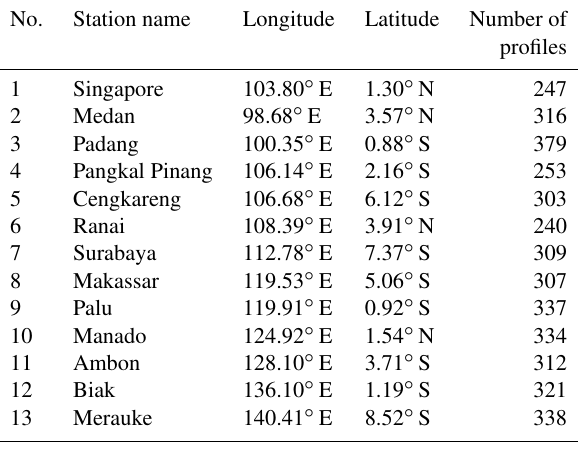
Table 1. Radiosonde stations for daily routine balloon launches during the CINDY-DYNAMO 2011 campaign around the Mar- itime Continent. All stations apart from no. 2 are in Indonesia. The “Number of profiles” column lists the number of successful balloon soundings that reached > 2km above the CPT.